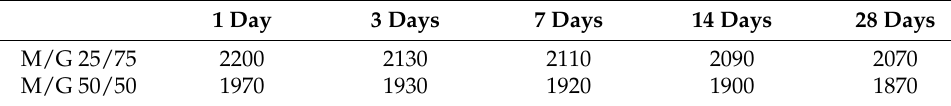
Table 5. Density of the geopolymers in the following curing days.